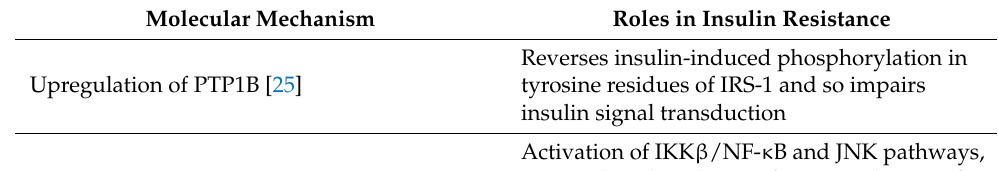
Table 3. Molecular mechanisms of insulin resistance